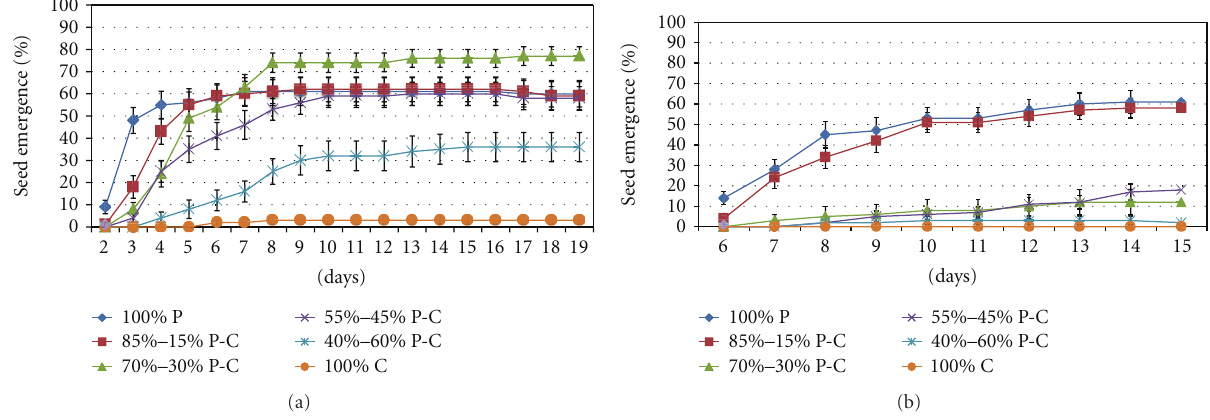
Figure 1: Influence of substrate medium (commercial peat: CP; municipal solid waste compost: MSWC) at di ff erent ratios on cumulative seedling emergence of marigold and basil seeds germinated in greenhouse nursery. Values represent mean ( ± SE) of measurements made on 5 independent replication (4 wells per replication; 5 seeds per well) per treatment.